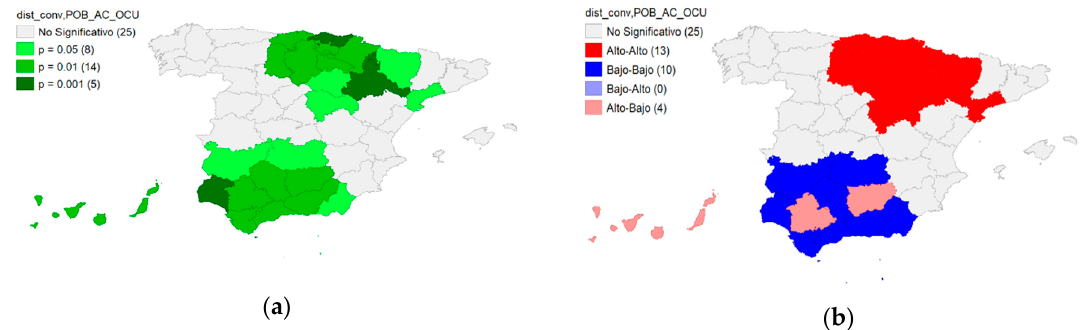
Figure 13. Significance map ( a ) and clusters map ( b ) for the variables Iag success and employment level.